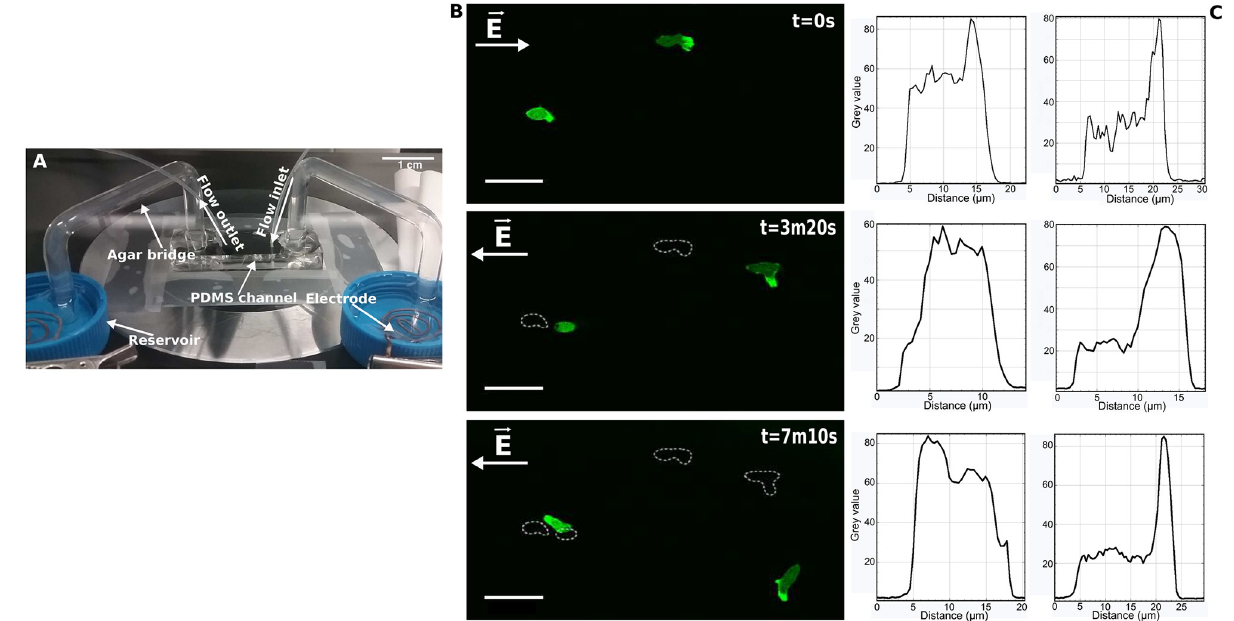
Fig 1. Experimental set up and F-actin polymerisation. A. Experimental set up. The electric field in the channel is generated through an indirect contact with the electrodes. The buffer reservoirs provide the electric connection between electrodes and agar bridges (for more technical details refer to Materials and Methods section). B. F-actin polymerisation through LimE-GFP. Cells with different morphology use different strategies to reverse their trajectory when the polarity of the electric field changes. The cell on the left rounds, extends a pseudopod in the new direction and forms a new leading edge whereas the cell on the right reverses its trajectory by doing a U-turn. The dashed lines show the changing position of the two cells. Scale bar: 25 μ m. C. Histograms of fluorescence intensity within the cell representing the localization of F-actin. Distance refers to the gap from the center of the cell’s leading projection through the cell body (see S1 Fig in S1 File). The left and right graphs correspond to the cells on the left and the right of the picture, respectively. The change in position of F-actin from the front to the back in the cell on the left when the electric field is reversed is clearly visible, while in the U-turn cell the F-actin remains at the front.